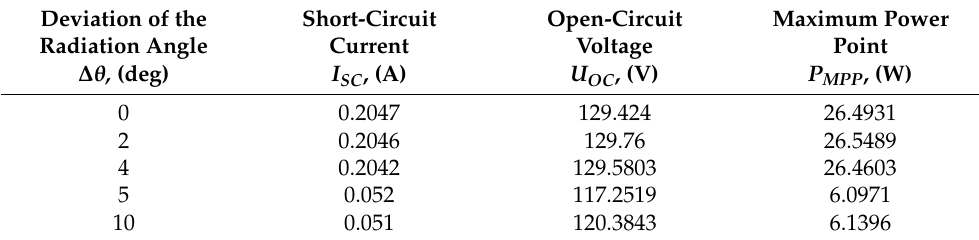
Table 3. Numerical results of current–voltage characteristics and power values for each deflection angle used in this simulation for a fixed irradiance of 300 W/m 2 and an assumed module temperature of 21 ◦